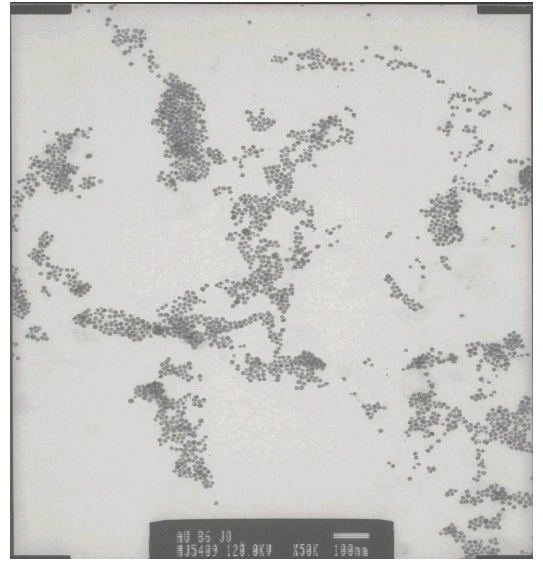
Figure 2. TEM image of colloidal gold